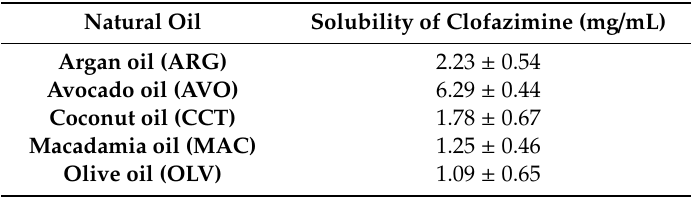
Table 2. Solubility of clofazimine determined in selected natural oils.